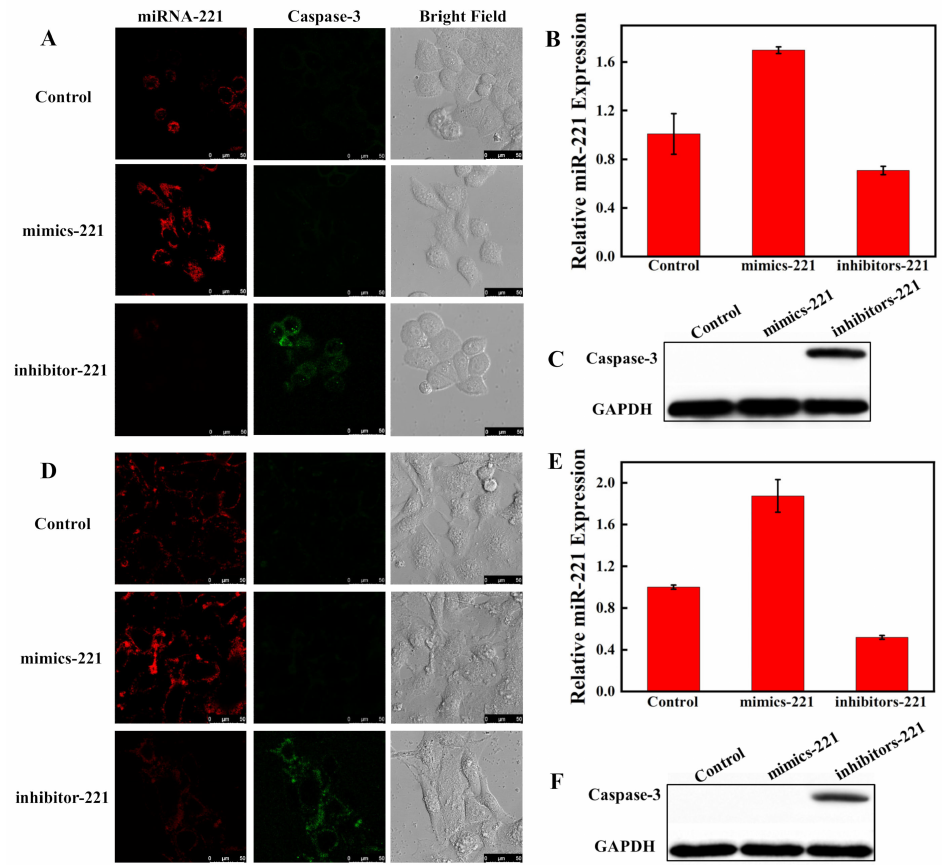
Figure 8. Visualizing miRNA regulation of apoptosis in Hela cells ( A ) and A549 cells ( D ) by CLSM. The cells were transfected with miRNA-221 mimics to activate the miRNA-221 level and transfected with miRNA-221 inhibitors to attenuate the miRNA-221 level, respectively. Scale bar: 50 µ m. Analysis of miRNA-221 expression by RT-PCR in Hela cells ( B ) and A549 cells ( E ) after transfection with miRNA-221 mimics and miRNA-221 inhibitors. The Western blot assay of caspase-3 expression in Hela cells ( C ) and A549 cells ( F ).